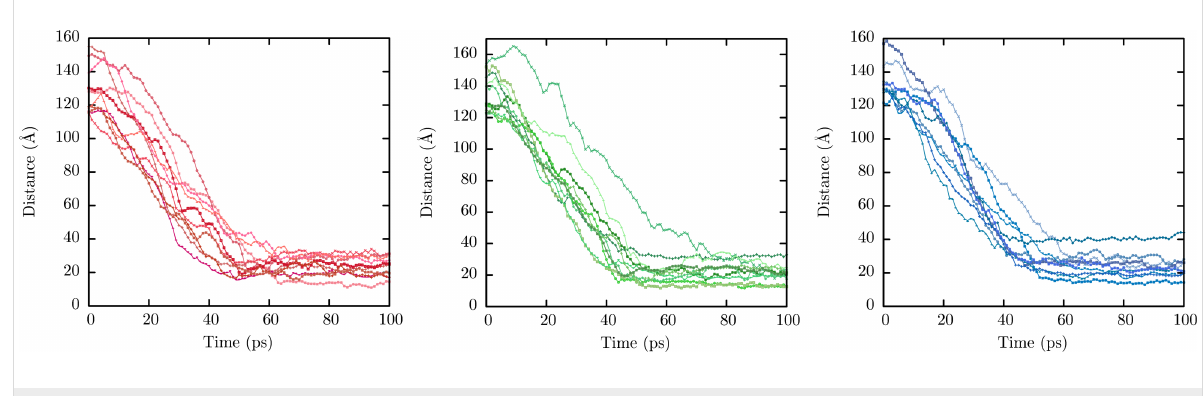
Figure 9: Distance between terminal groups from DSPE–PEG–lipid and center of mass of the PLA core as a function of time. Distances between COOH groups from an anionic nanoparticle and the center of mass of the PLA core are represented in ten different red-styled lines. Distances be- tween CH 3 groups from a neutral nanoparticle and the center of mass of the PLA core are represented in ten different green-styled lines. Distances between NH 2 groups from a cationic nanoparticle and the center of mass of the PLA core are represented in ten different blue-styled lines.